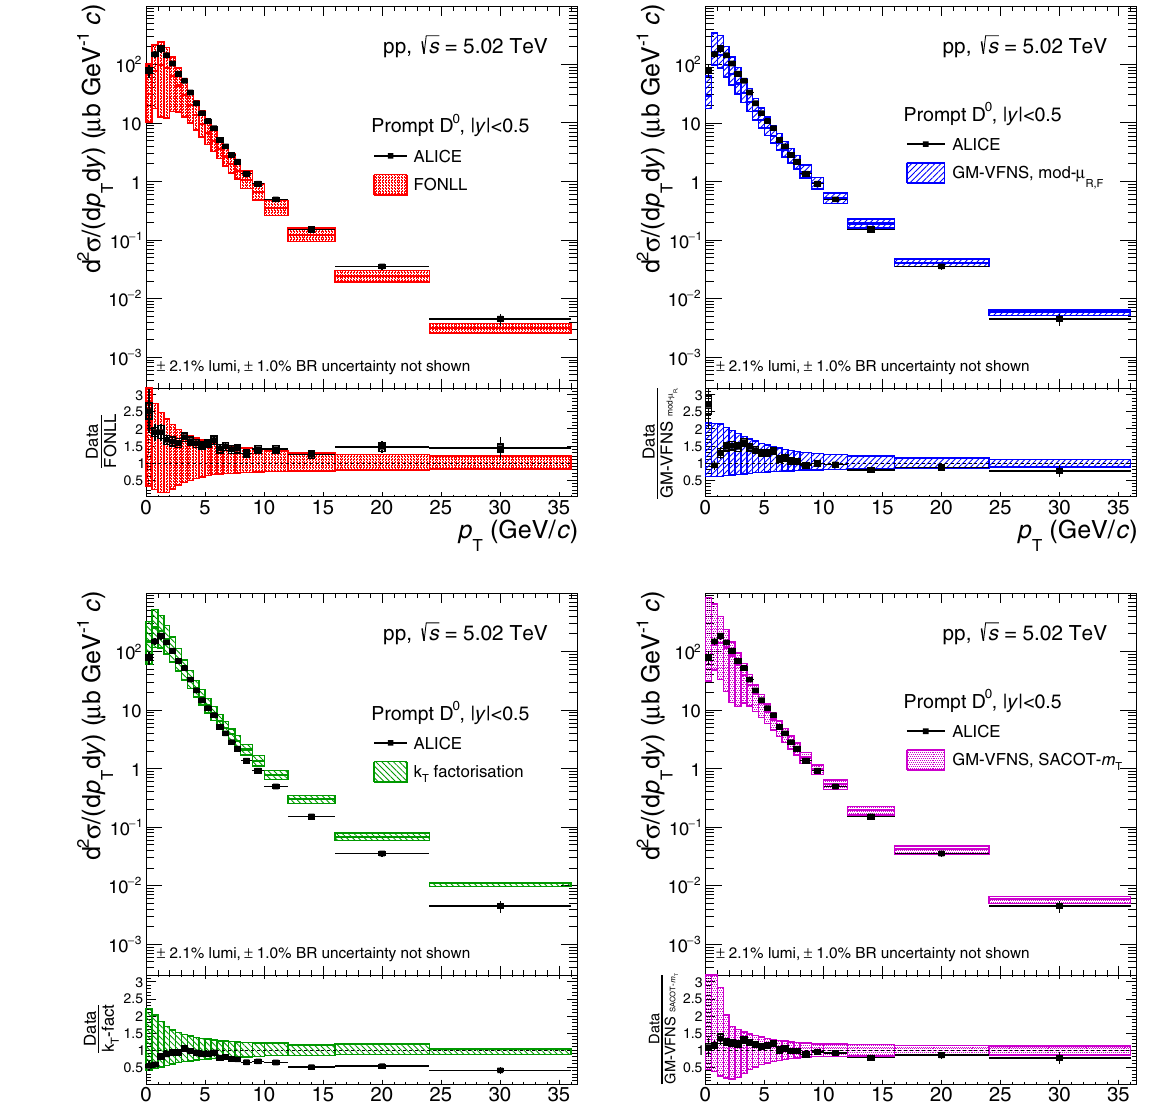
The systematic uncertainty on the (cid:7) p T (cid:8) was estimated as described in Refs. [19,27]. The contributions due to the cor- related and uncorrelated systematic uncertainties on the mea- sured p T -differential cross section were taken into account separately and the contribution due to the choice of the fit function has been estimated by comparing results obtained using different functions and using a method based on direct calculations of (cid:7) p T (cid:8) from the data